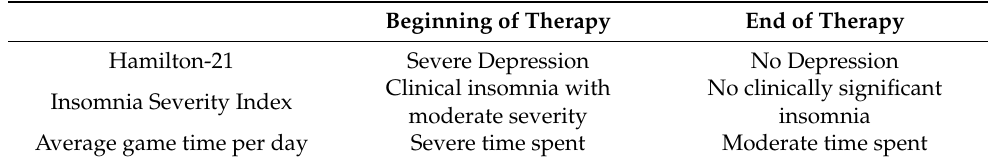
Table 1. Pre and post